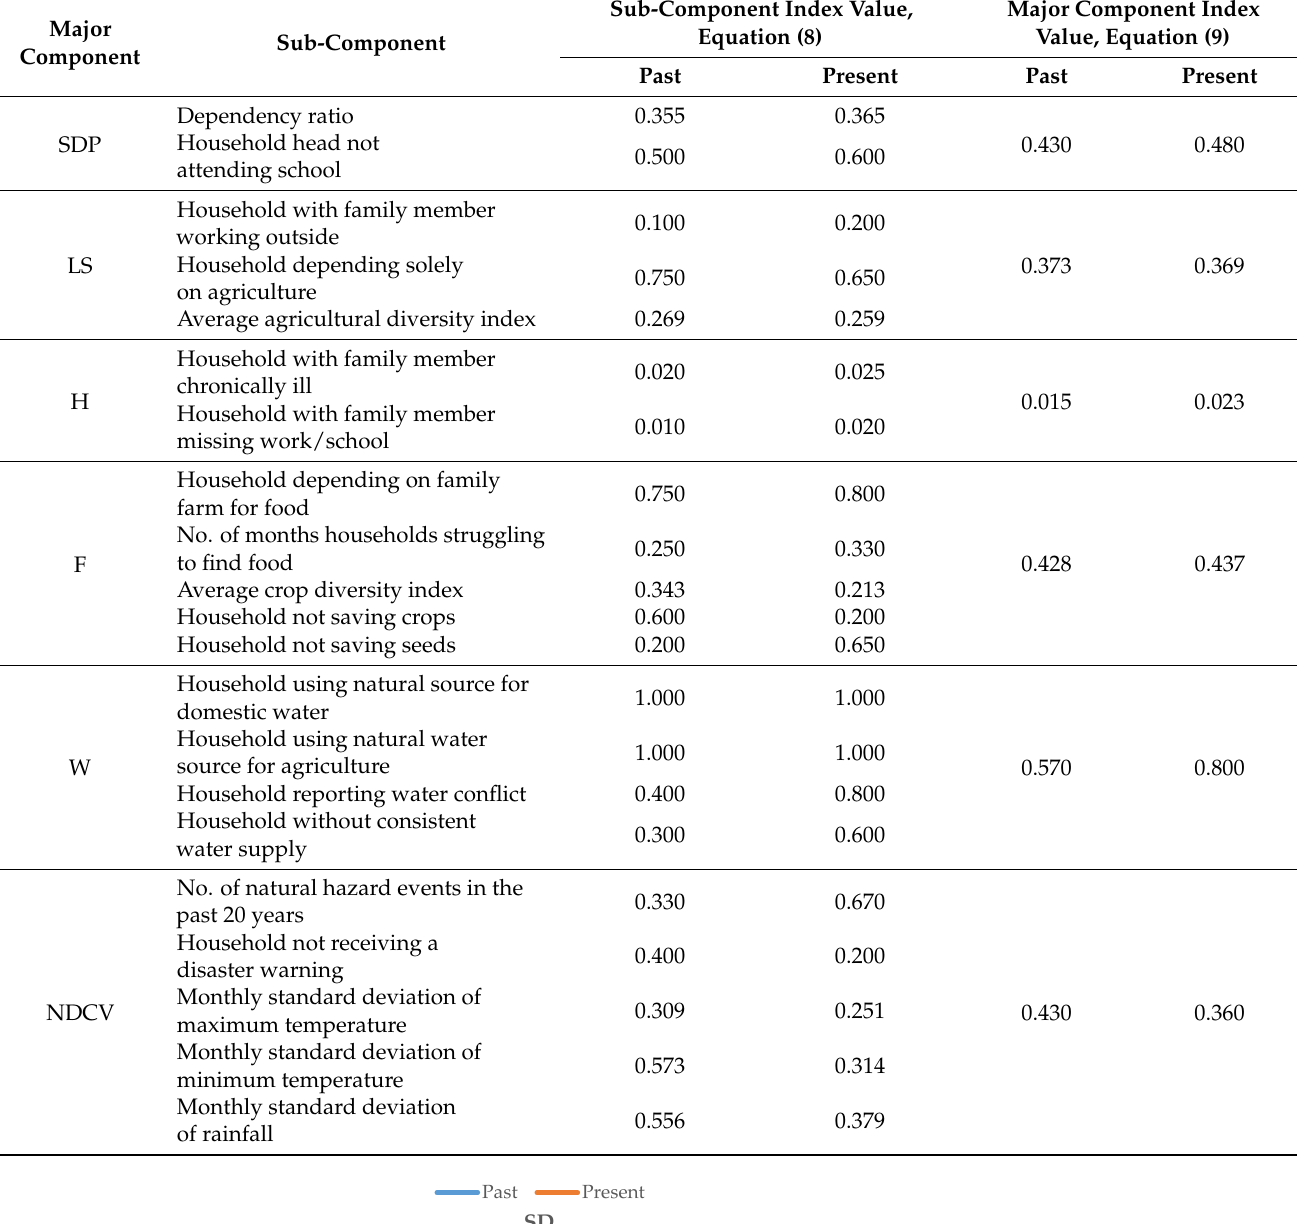
Table 7. Sub-component and major component LVI for the past and present decades in Polder 31.